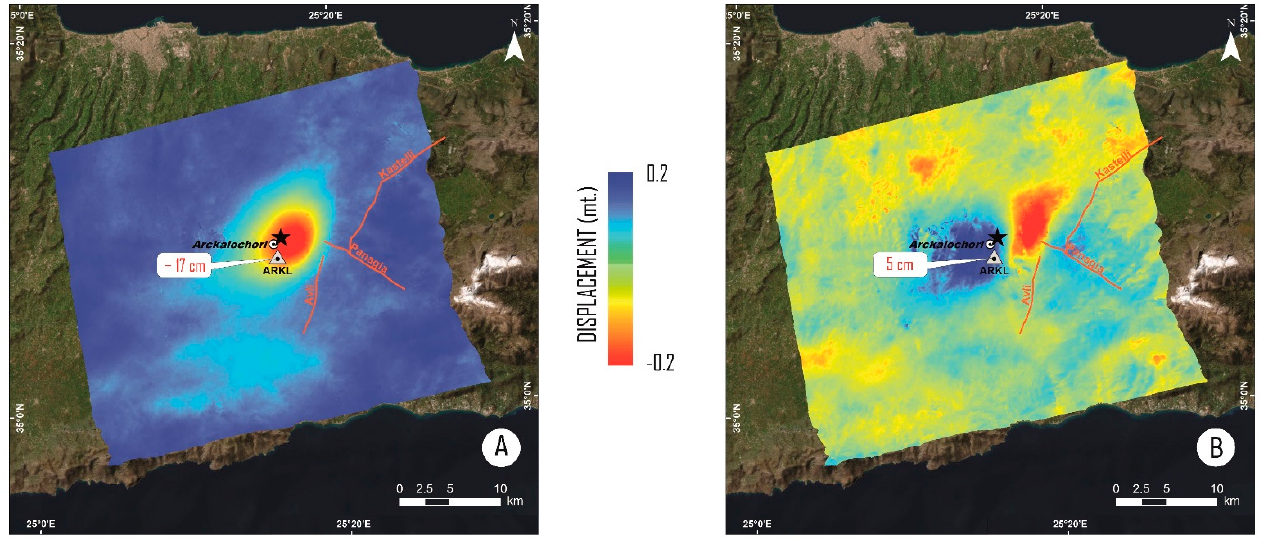
Figure 7. Vertical ( A ) and E–W ( B ) InSAR deformation components with relative GNSS ARKL Station co-seismic offset values.